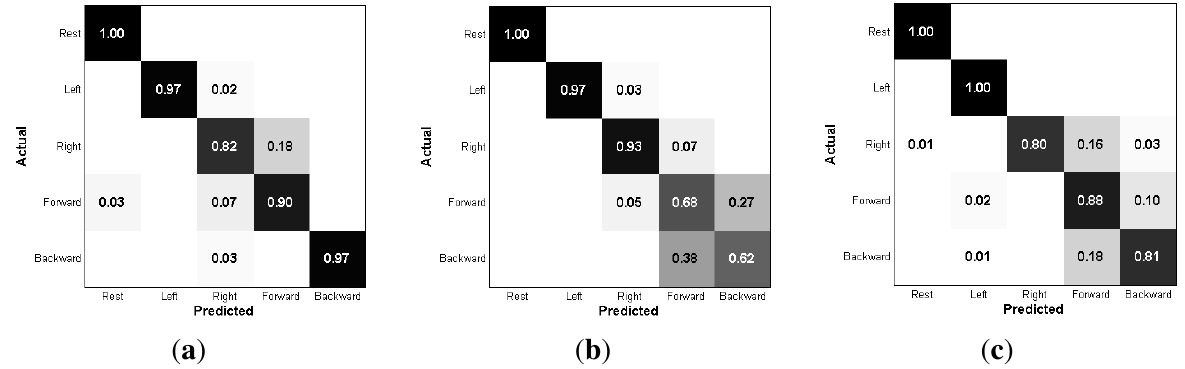
Figure 15. Confusion matrix of three types of electrodes (Subject 1). The commercial wet and dry electrodes showed higher error rates between motions, which means that the proposed MNA electrode has a higher selectivity of motions. ( a ) Proposed MNA electrode; ( b ) commercial wet electrode; ( c ) commercial dry